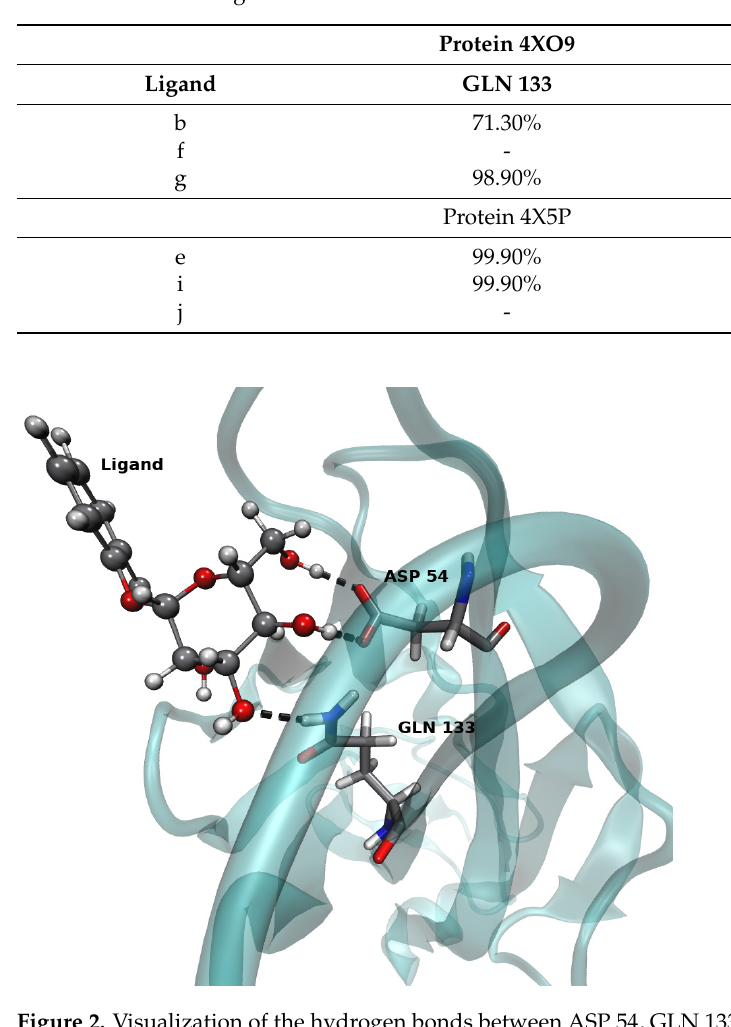
Table 7. Percentage of simulation time when the hydrogen bonds with ASP 54 and GLN 133 were formed for different ligands.